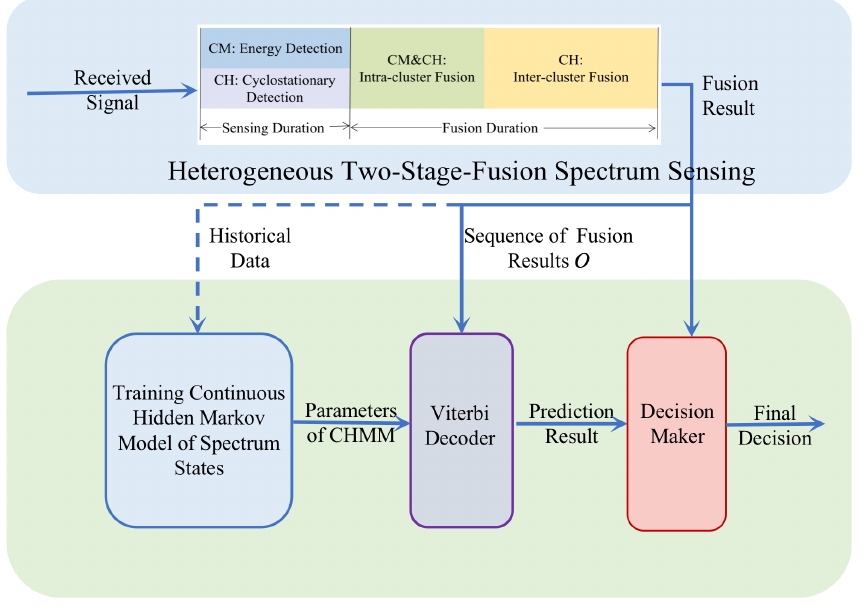
Figure 3. CHMM-based Spectrum